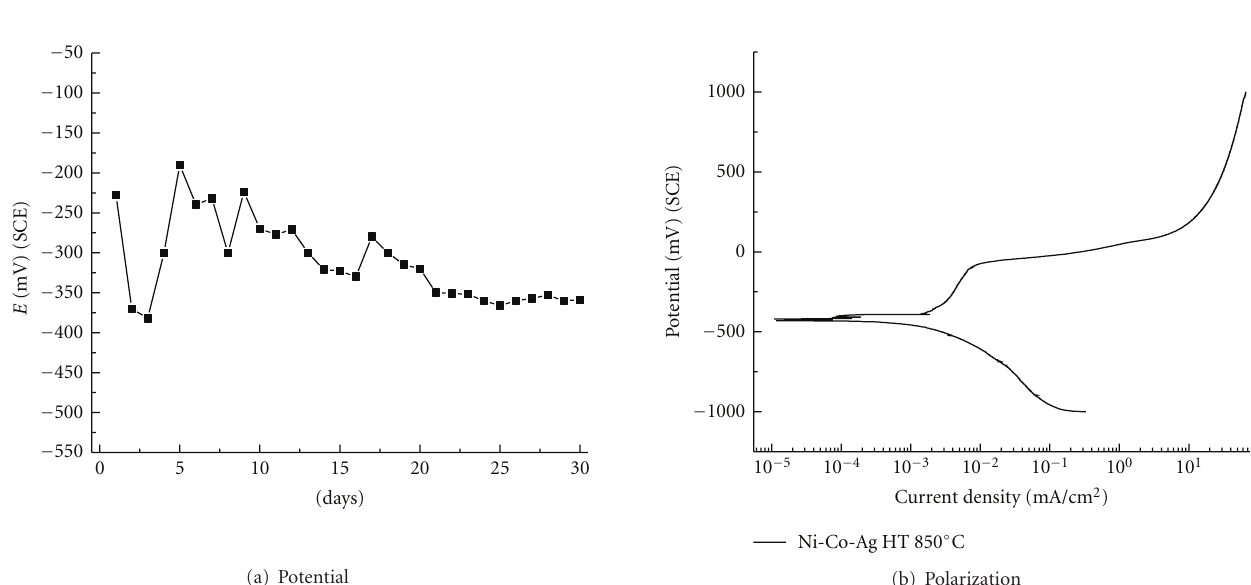
Figure 3: Corrosion potential as a function of time and polarization